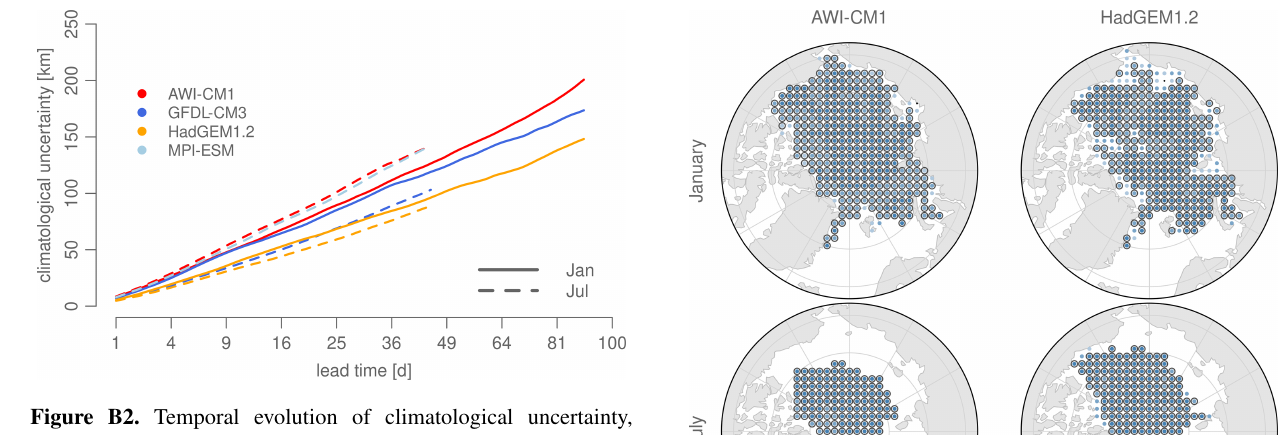
Figure B2. Temporal evolution of climatological uncertainty, i.e., the length of the semi-major axis of the variance ellipse. Note the square root horizontal axis.